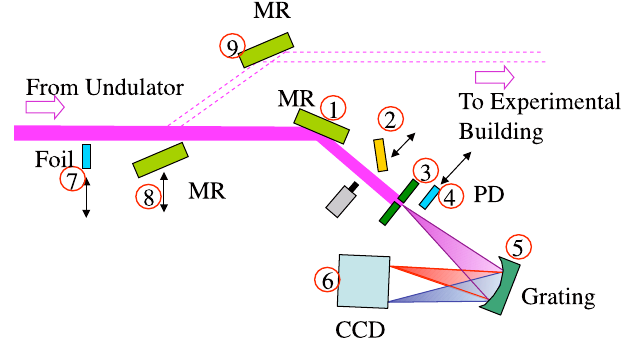
FIG. 3. (Color) Schematic representation of the photon diagnos- tics system. 1, deflecting plane mirror (MR); 2, fluorescence screen; 3, incident slit; 4, photodiode (PD); 5, concave grating; 6, charge-coupled device (CCD); 7, thin-foil attenuator; 8 and 9, mirrors used for transporting EUV radiation to the experimental building. The double arrow represents a retractable component.